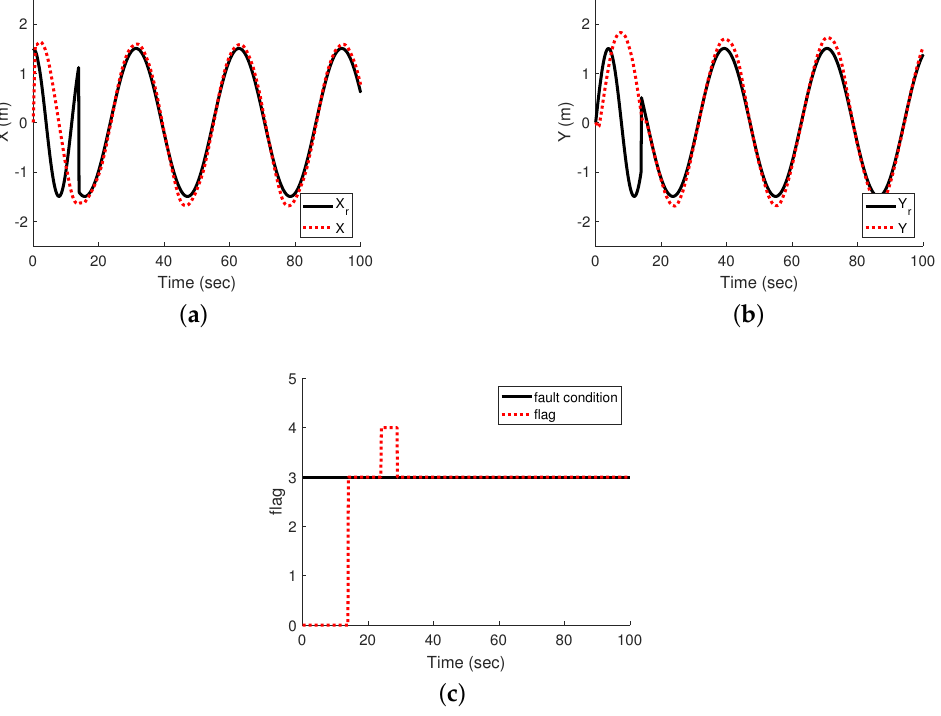
Figure 11. Online fault detection and toleration result. ( a ) X position. ( b ) Y position. ( c ) Fault detection